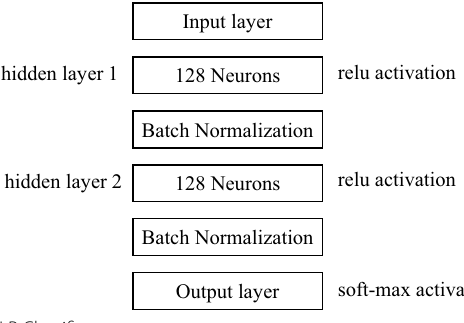
Fig. 5 Our Specified MLP Classifier